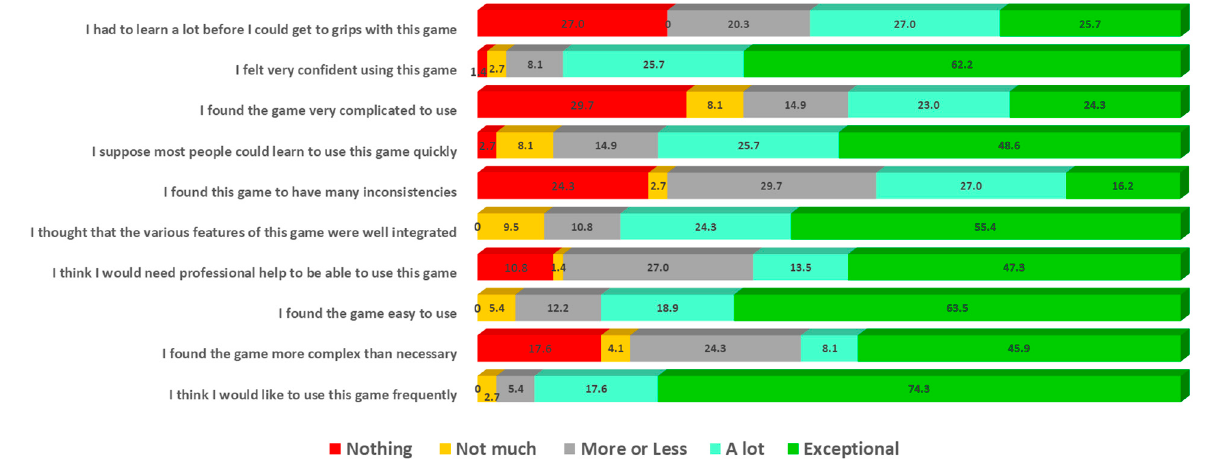
Figure 2. SUS items score %. Table 1. Statistic parameters SUS